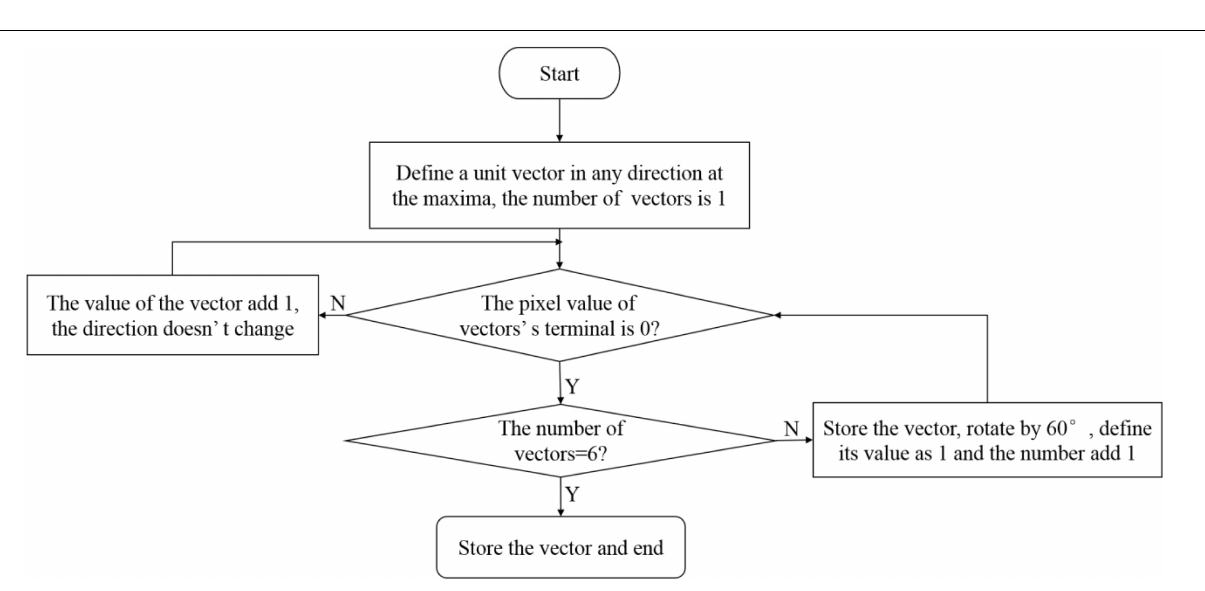
FIGURE 13 | The process of determining the radius of the overlapping target